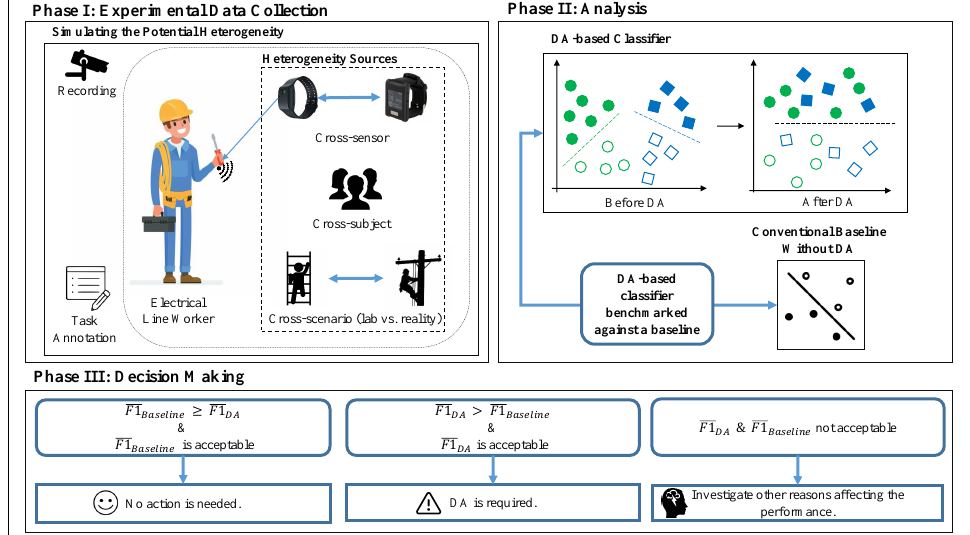
Figure 1. An overview of the proposed framework ( ¯ F 1 Baseline and ¯ F 1 DA represent overall F1 score obtained from a SVM classifier and a SVM classifier equipped with DA, respectively.)